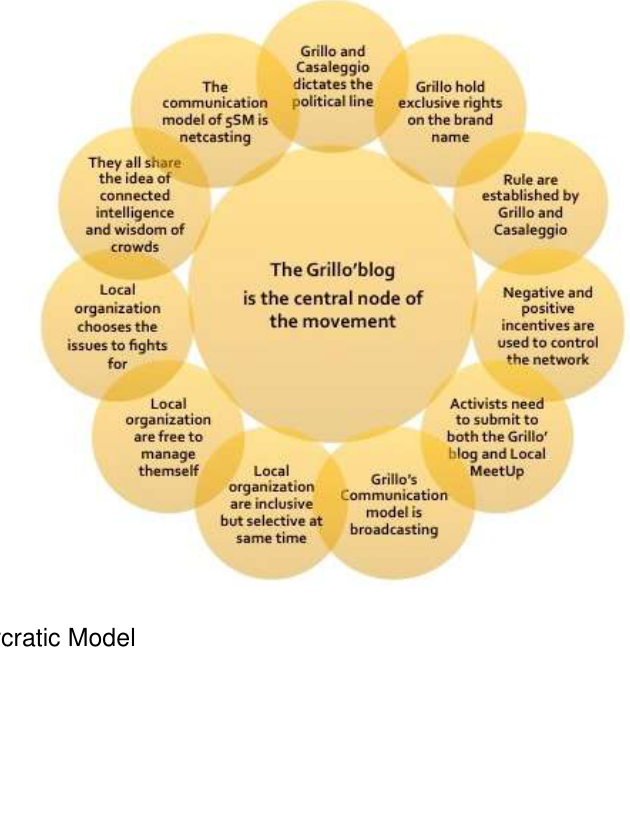
Figure 2: 5SM Cybercratic